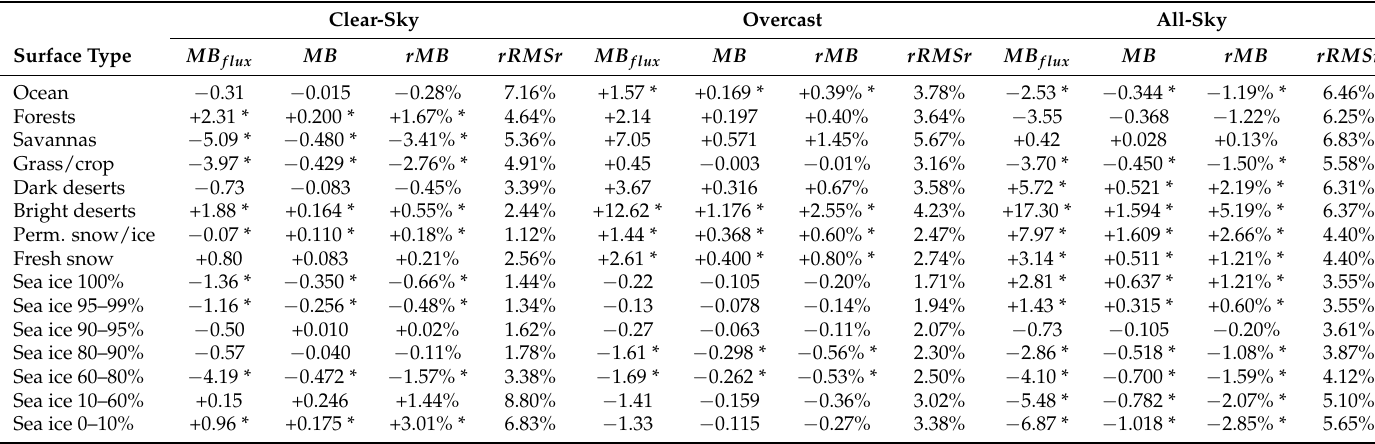
Table A1. Generic surface-type-independent regression performance based on smaller validation subset (20% of the observations with strict matching criteria), stratified per surface type, for clear, overcast, and allsky conditions; Data: 2004–2005 (NOAA17+Terra), 2007–2008 (NOAA18+Aqua) and 2011–2012